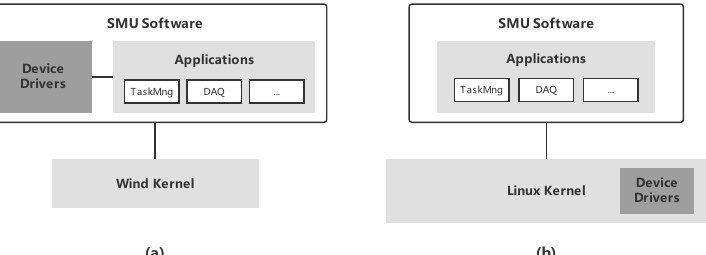
Figure 3. Comparison between SMU software architecture based on VxWorks and Linux. ( a ) SMU software architecture based on VxWorks. ( b ) SMU software architecture based on